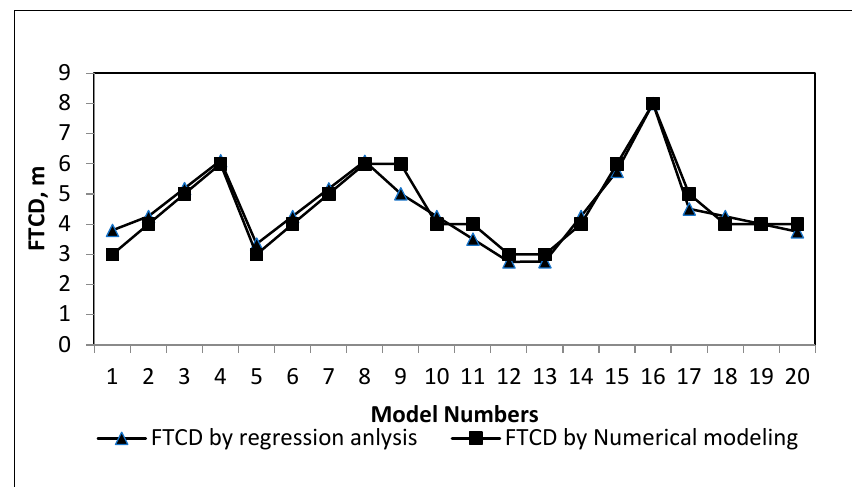
Figure 8. The FTCD obtained by regression and numerical modeling.